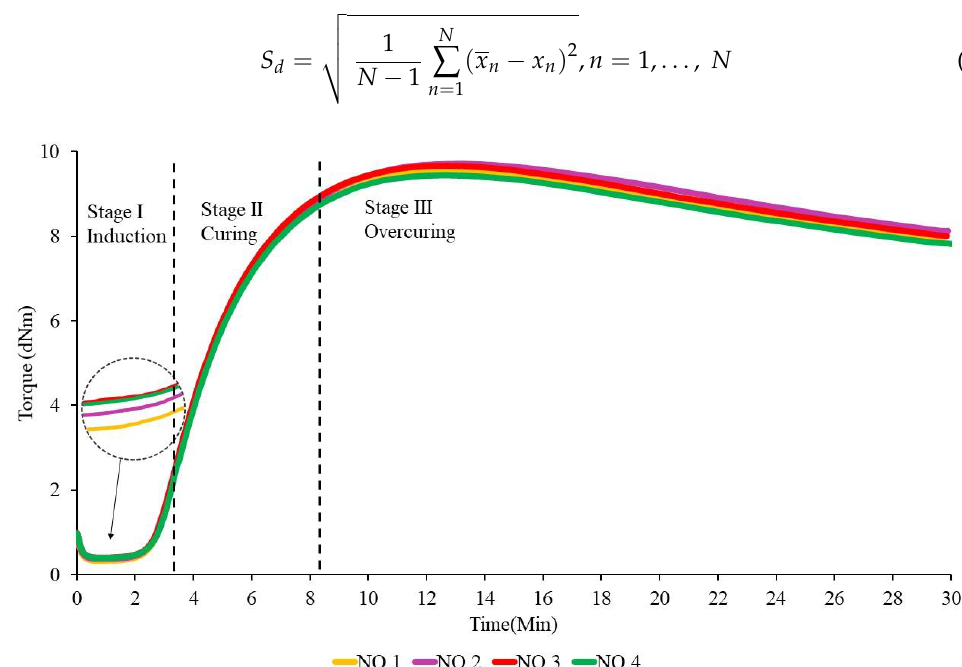
Figure 1. The curing curves of NR-based MREs for different ratios of NO:AO.